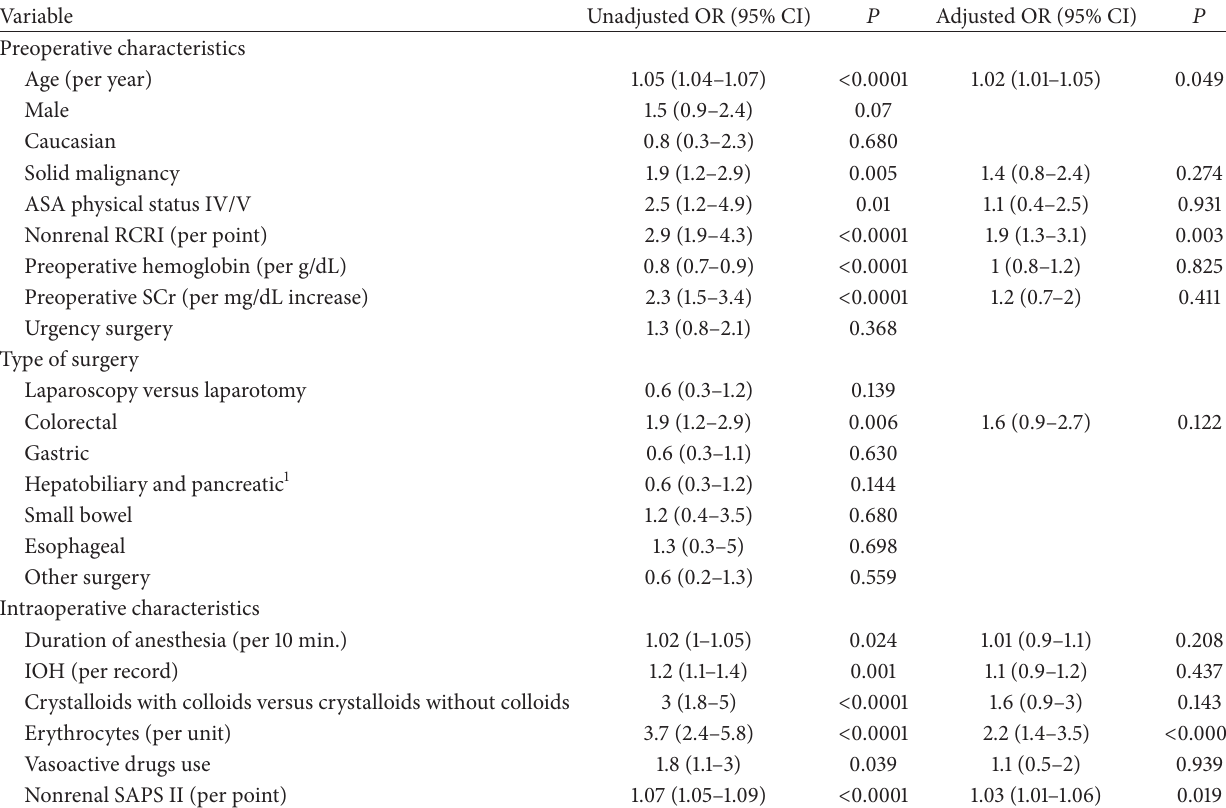
Table 3: Univariate and multivariate analysis to determine risk factors of postoperative acute kidney injury.